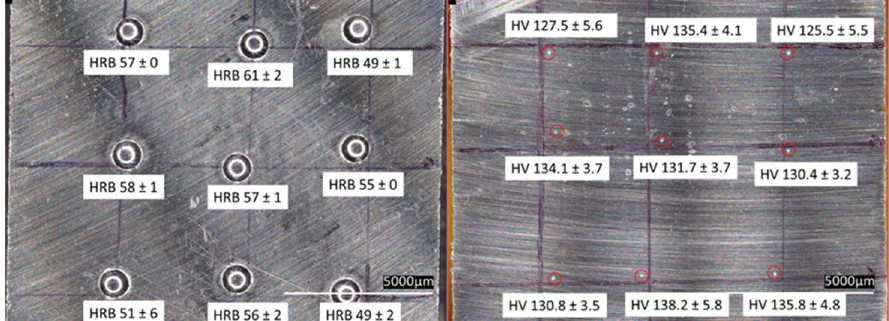
Figure 8. Rockwell B Hardness ( left ) and Vickers hardness ( right ) values in their relative positions within the sample.